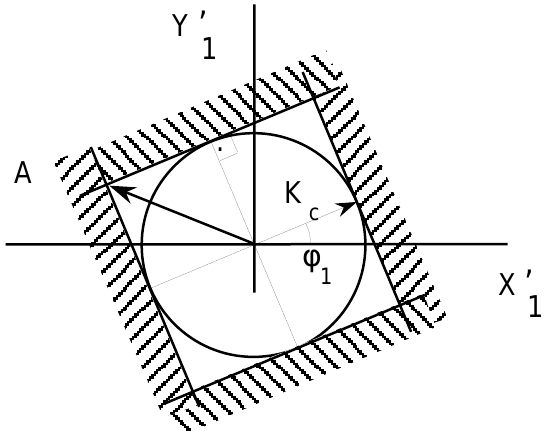
FIG. 2. The polygon delimited by the secondary jaws in the (cid:88) 0 (cid:45) (cid:89) 0 plane. Here (cid:109) (cid:115) (cid:173) (cid:52) . The scattering azimuth are chosen equidistant to form a square which minimizes the surface and the extension of the polygon. The largest angle passing the p secondary jaws is (cid:75) (cid:52)(cid:44) max (cid:173) k (cid:79)(cid:65) k (cid:173) (cid:50) (cid:75) (cid:99)